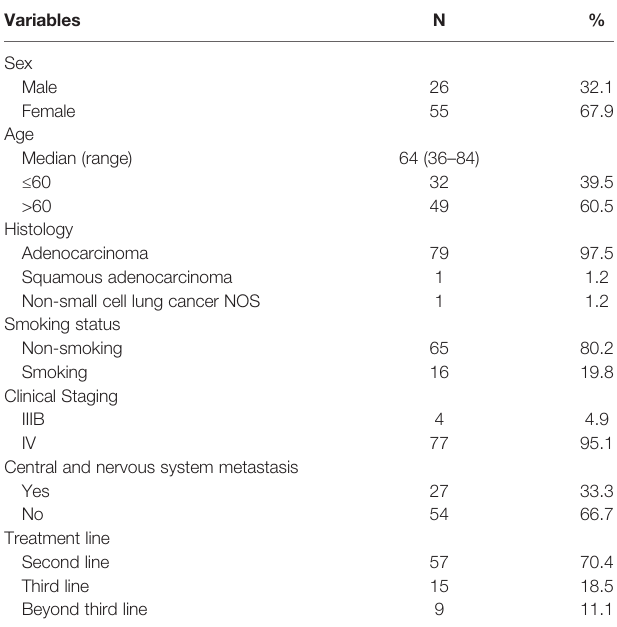
TABLE 1 | Patient characteristics at pretreatment of third-generation EGFR